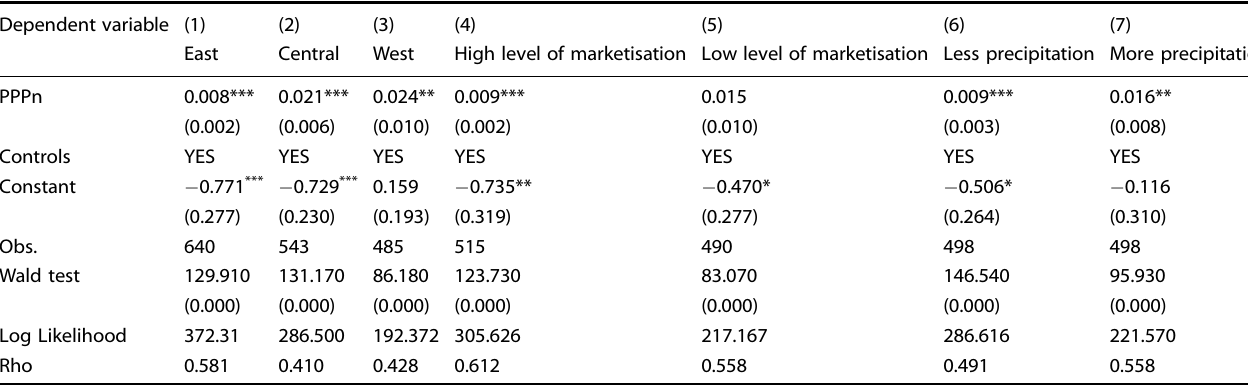
Table 8. Heterogeneous